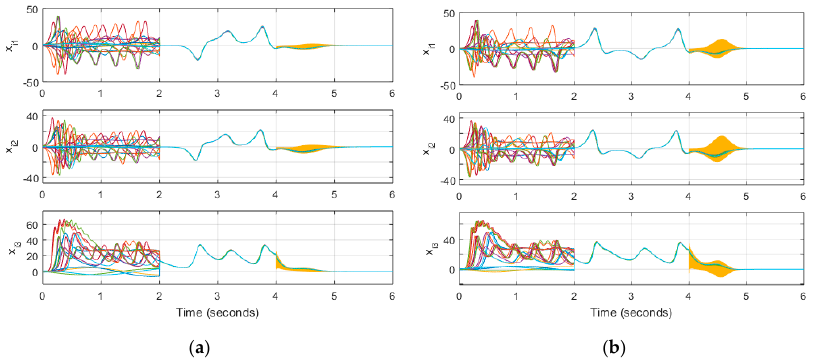
Figure 6. Complex network node dynamics when there is one controller, there is no noise in the system, and: ( a ) Control input is applied every 5T with a control gain d 3 = 1000; ( b ) Control input is applied every 10T with a control gain d 3 = 1500.